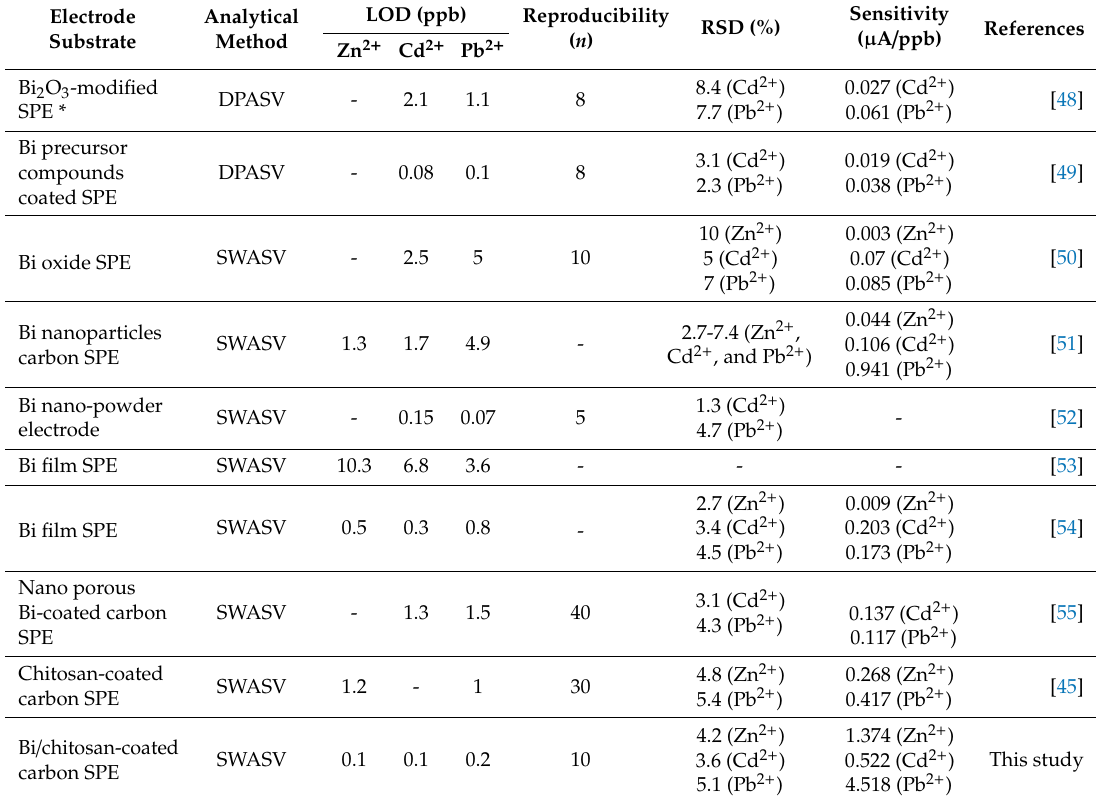
Table 1. Comparison of heavy metal detection between the developed Bi / chitosan-coated sensor and other Bi film sensors previously